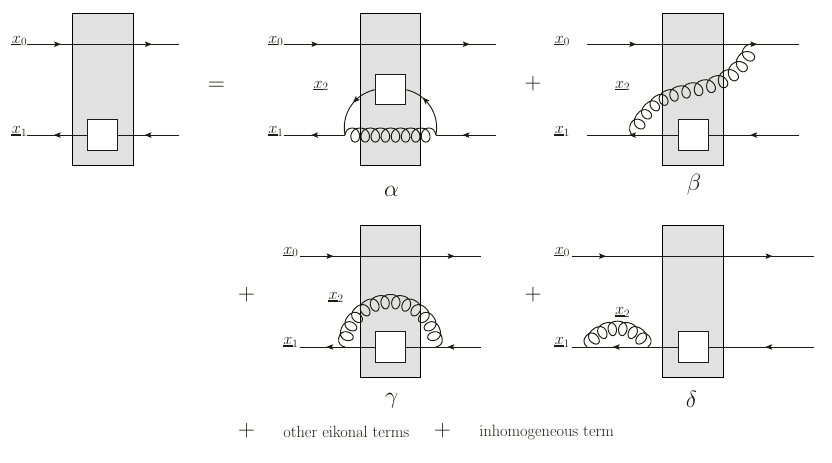
Figure 5. The main types of diagrams contributing to the DLA evolution of the amplitudes H 1 ( z ) and H 2 ( z ) from eq. (3.23). The diagram α on the right contains a sub-sub-eikonal soft- 10 10 quark emission, while the remaining diagrams β,γ,δ , etc. are a sample of the eikonal emission diagrams [90,